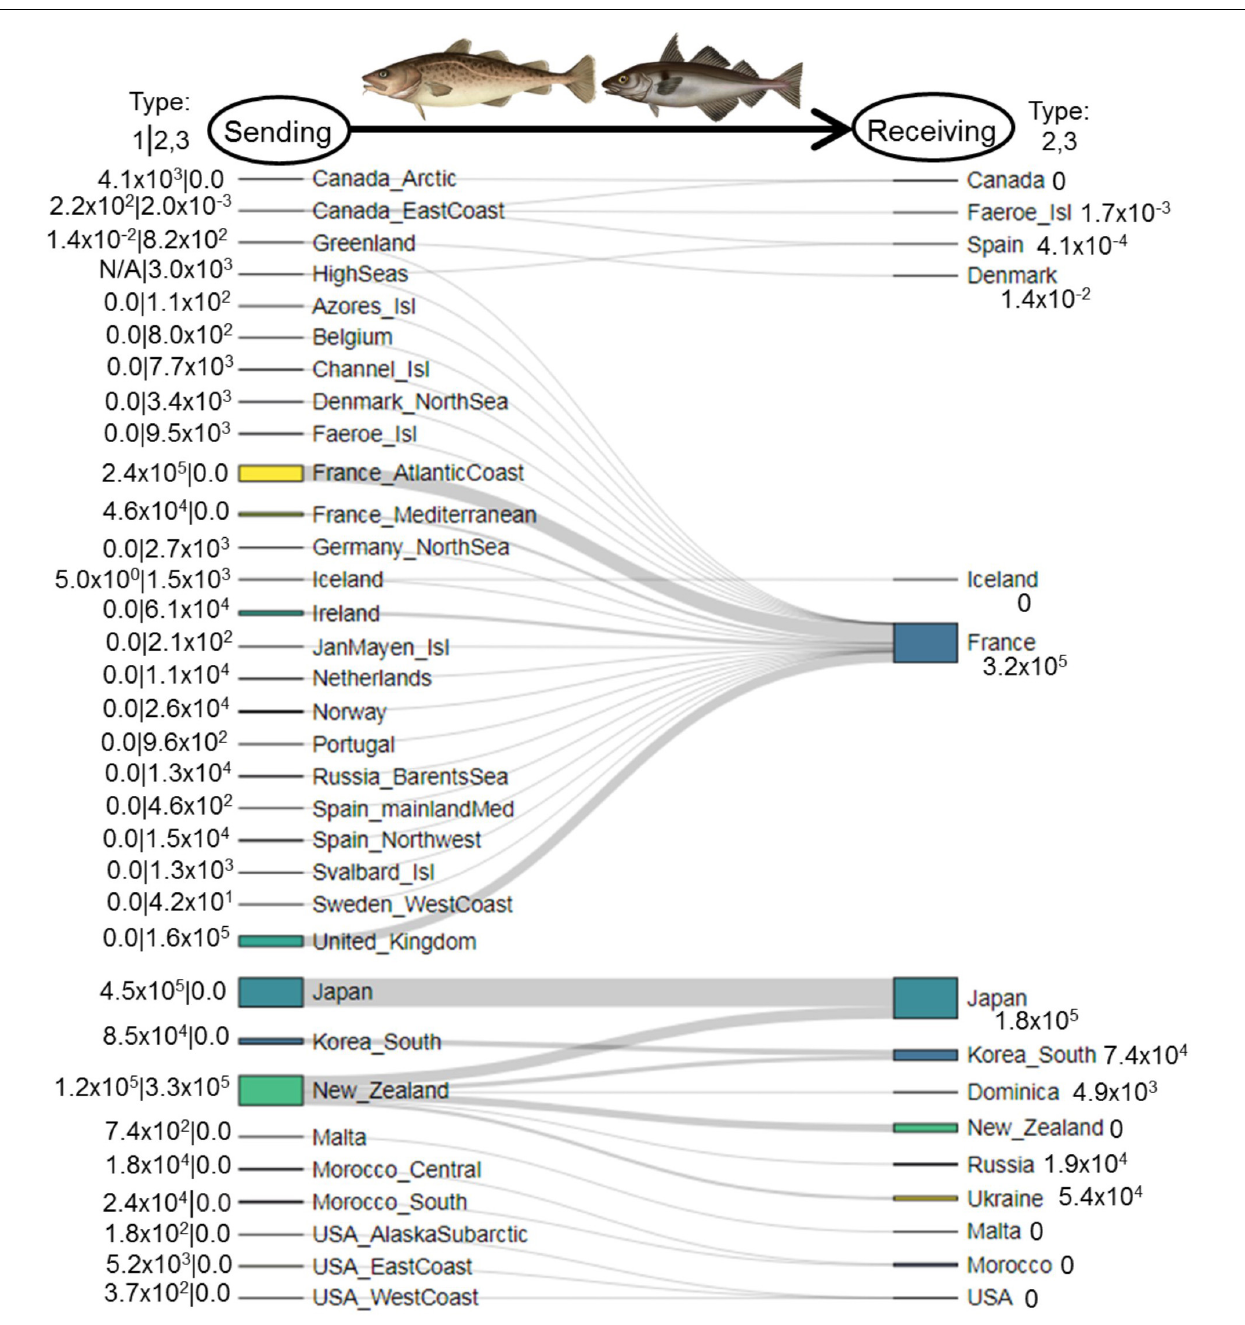
FIGURE 5 | Sankey diagram depicting flows of cods (family Gadidae, metric tons) from sending systems (left) to receiving systems (right) in 1950–2014, organized by exclusive economic zones (EEZs). In the left margin, numbers to the left of the divider represent Type 1 fishing—total catches by each nation within its own EEZ(s). Numbers to the right of the divider represent Type 2/3 fishing—total catches in each EEZ by other nations. Numbers in the right margin are Type 2/3 catches by each nation in other